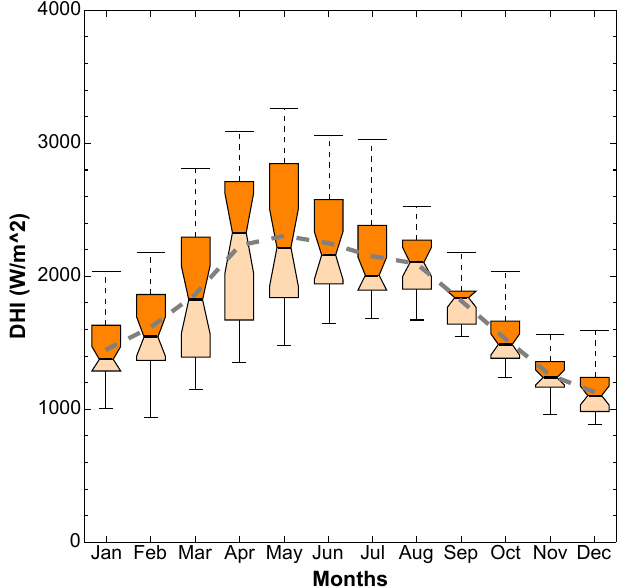
Figure A1. Notched boxplots show the daily variability of GHI for each month; the dashed line shows the mean values.